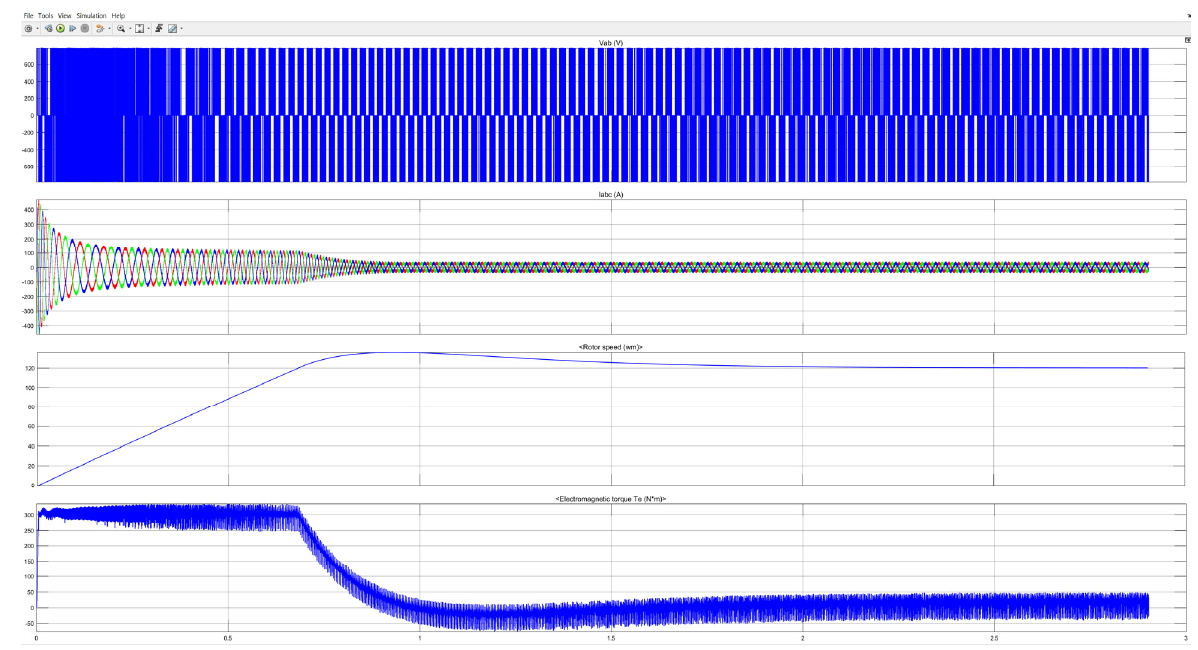
Figure 2. Diagrams of voltage changes between two phases, electric current in three phases, angular speed of the motor and torque.